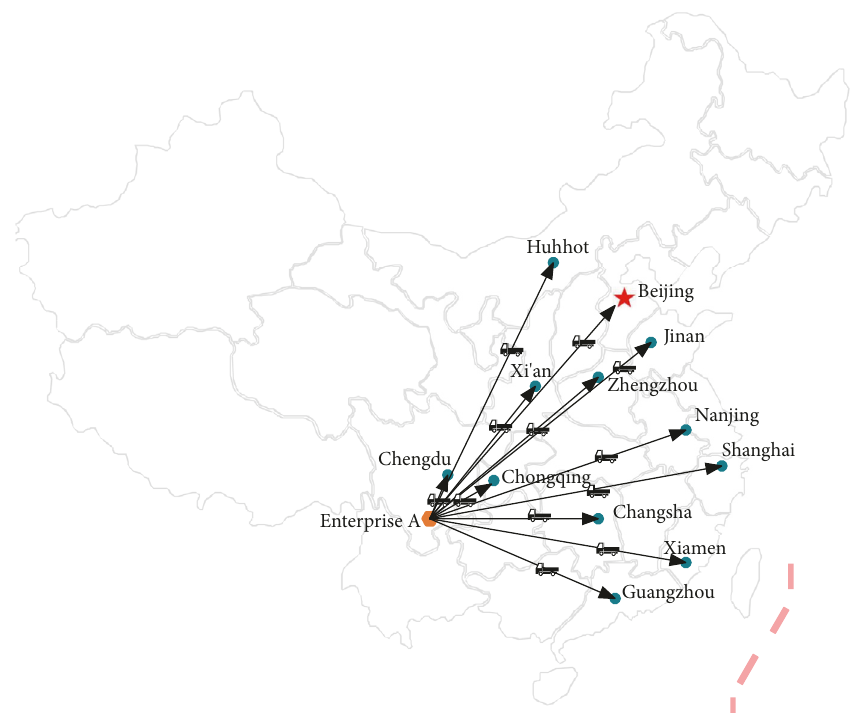
Figure 5: Realistic distribution roadmap for Enterprise A,